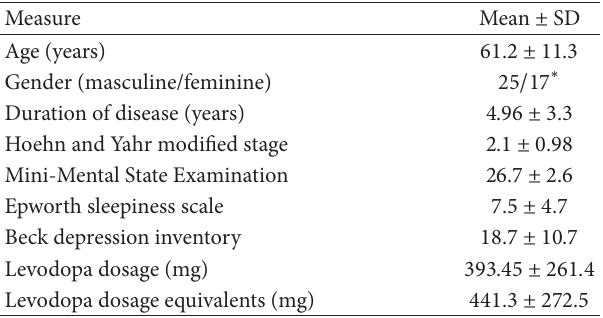
Table 1: Descriptive statistics ( 𝑛 = 42